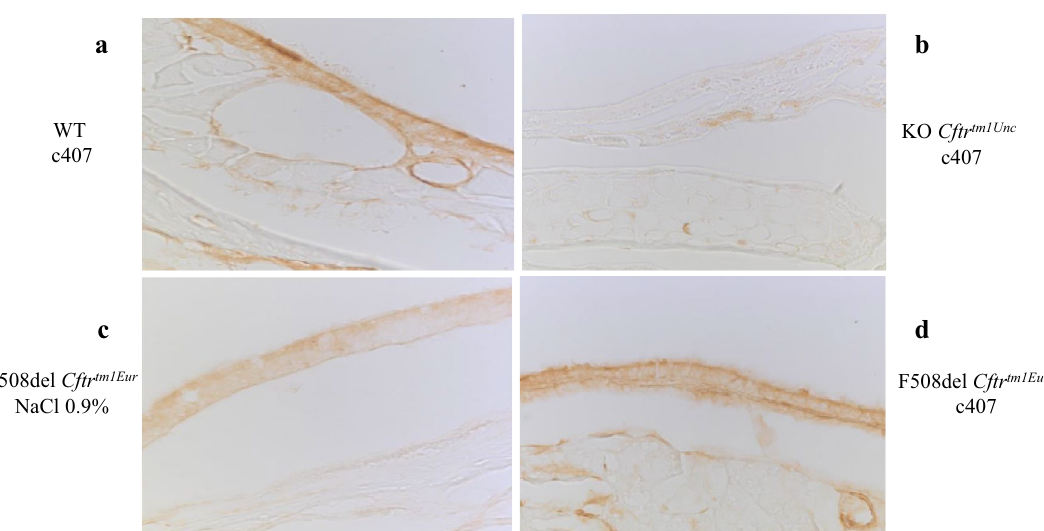
Figure 4. CFTR immunostaining of nasal epithelium in CF mouse models. ( a ) WT Cftr tm1Eur mouse. ( b ) KO Cftr tm1Unc mouse. ( c ) F508del Cftr tm1Eur mouse treated with NaCl 0.9% subcutaneous administration. ( d ) F508del Cftr tm1Eur mouse treated with c407, subcutaneous